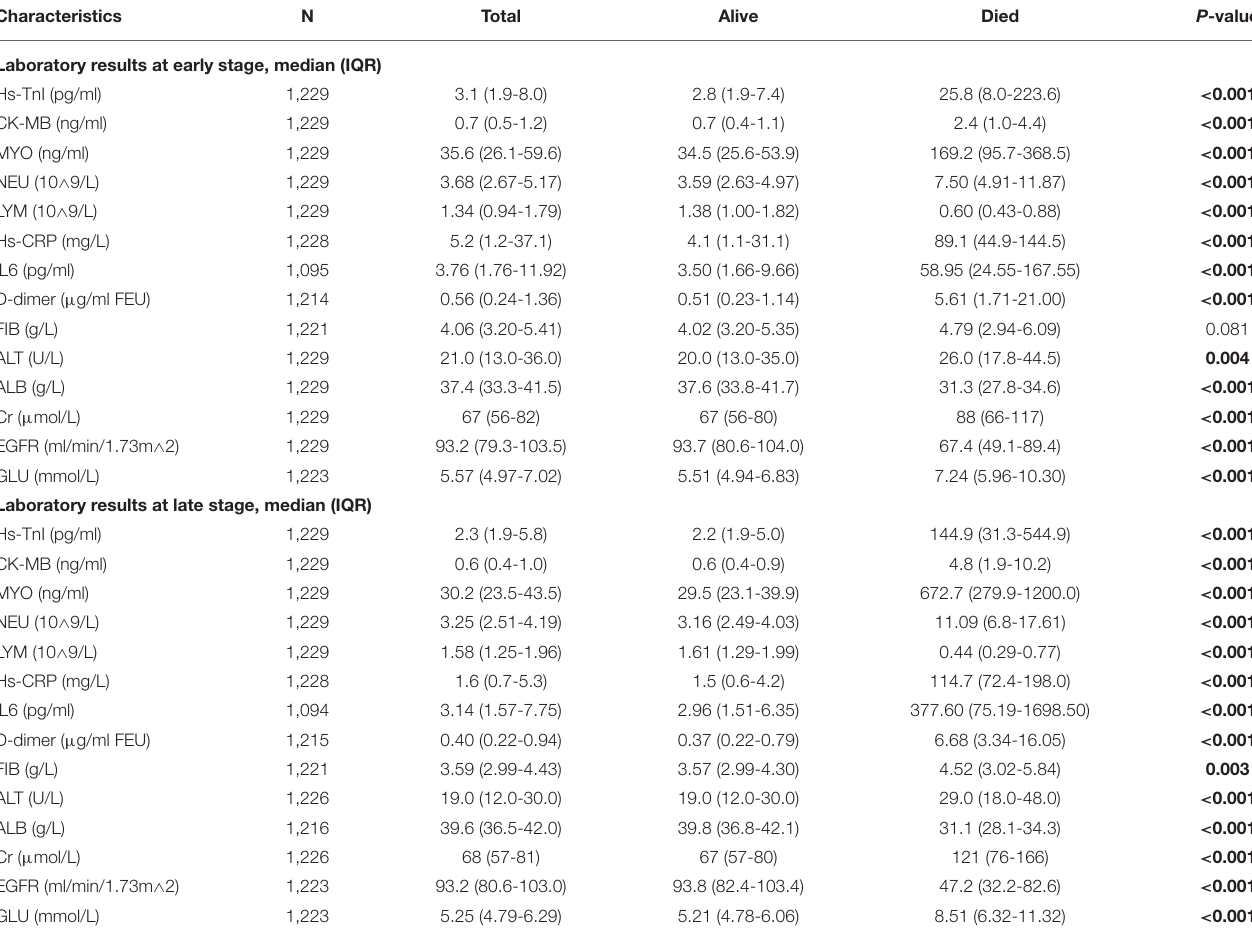
TABLE 2 | Laboratory findings at the early and late stages of hospitalization in overall study patients and patients stratified based on mortality. Characteristics N Total Alive Died P -value Laboratory results at early stage, median